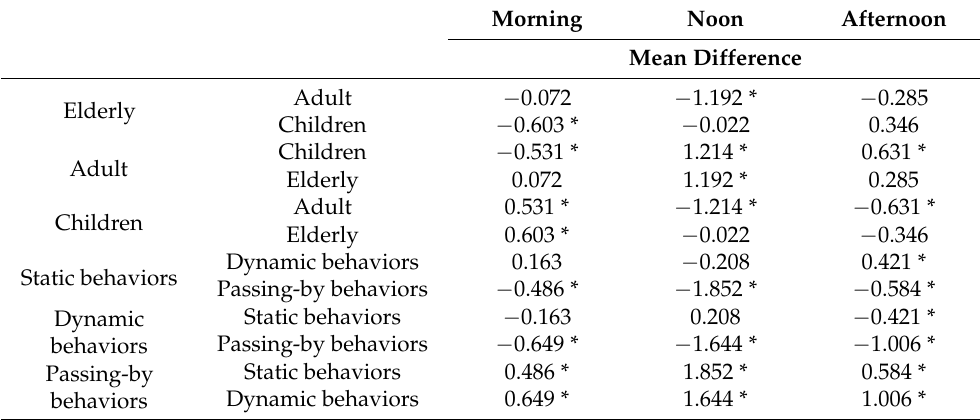
Table 6. Multiple comparisons analysis of temperature preferences for age groups and behavior